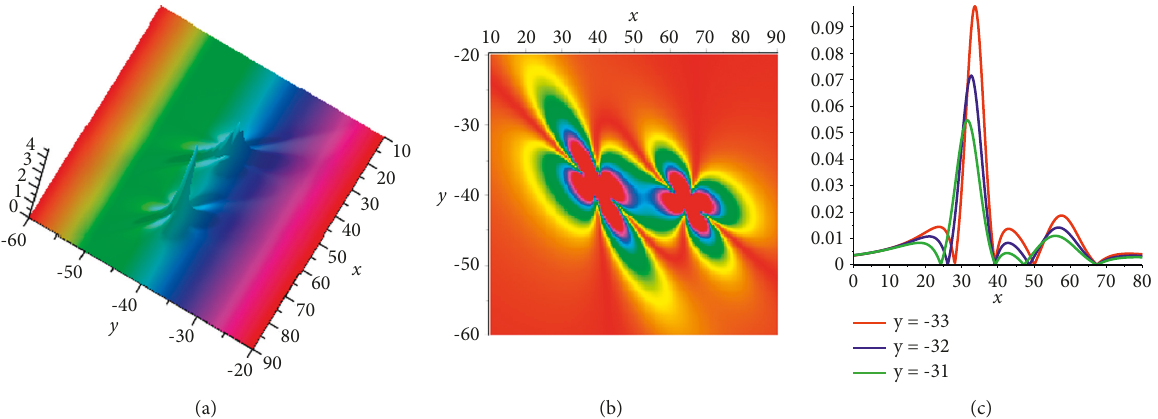
Figure 9: Plot of equation (50) by taking a � c � d � e � c (c) f